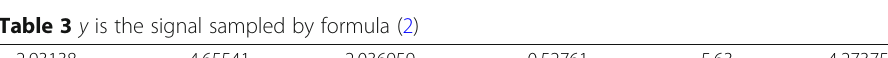
Table 3 y is the signal sampled by formula (2) − 2.93138